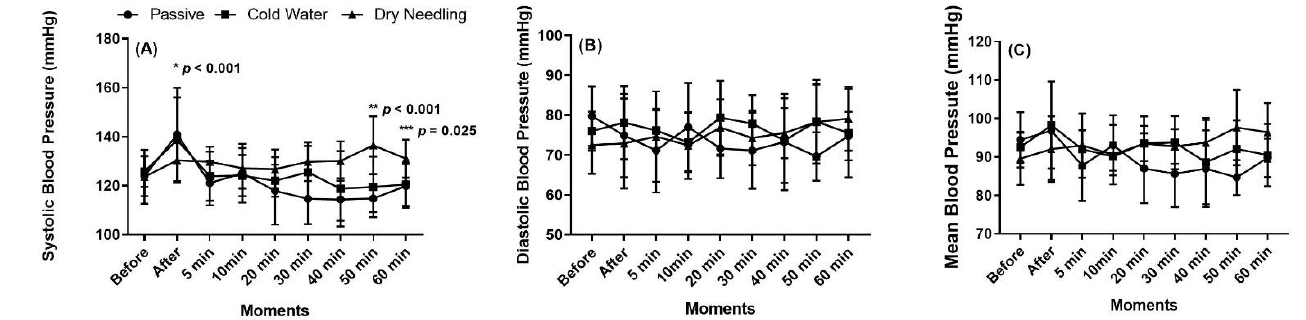
Figure 2. Systolic ( A ), diastolic ( B ) and mean ( C ) blood pressure, before and until 60 min after the training session followed by the three recovery methods. * Difference between dry needling and passive recovery. ** Difference between cold-water and passive recovery. *** Difference between dry needling and passive recovery.